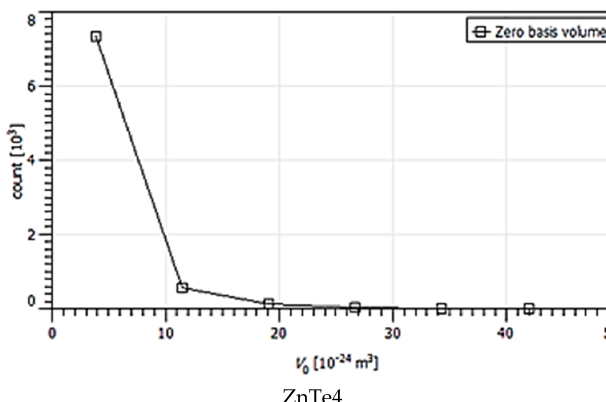
Figure 8. Zero basis volume statistic variation of ZnTe1,2,3,4 thin films. Although the surface becomes flatter when the film thickens, it can be observed that the majoritarian grain on the surfaces remained the same, i.e., ~9–10 nm radius size for all of the films. The projected grain boundary values are also quite close—from 29 to 34 nm, while surface area and grain volumes are obviously more different due to strong surface texturing and a z-range drastic decrease. The surface-to-volume ratio is the amount of the surface area per unit volume of an object or collection of objects; in this case, the grains forming the film surface. It defines the relationship between the structures and functions in processes occurring through the surface and the volume of the film/layer. For the ana- lyzed ZnTe thin films, the estimated surface to volume ratio was highest for the thinner film and was the lowest for the thicker. Additionally, the minimum circumcircle radius for each kind of grain detected on the surfaces, and the mean z-value were estimated for each above-presented AFM image, and are presented in the Figures 4–8. Table 1 presents the mean calculated values for the ZnTe films surface characteristic grains (specific surface area, grain volume, grain boundaries lengths, and surface to volume ratios) that can be further connected with the film growth mechanisms and physical properties. Based on Figures 4–8 that present the dimensional distribution of these surface characteristic pa- rameter values for each of the films, the proper estimation of majoritarian grains is con- firmed, and information regarding the other non-majoritarian grains (number and size ranges) present on the samples surfaces is provided. This offers the most complete kind of characterization regarding surface properties of the ZnTe films that one could obtain. The Figures 4–8 show the dimensional distributions of each parameter value onto the 2 μ m × 2 μ m surface scans (Figure 4). To better analyze the surface roughness evolution, examples of three-dimensional (3D) AFM images of ZnTe films obtained from larger scan sizes (5 μ m × 5 μ m) are shown in Figure 9. The z-range of the specific 3D representations was chosen to be equal to the highest feature onto the surface, as a better way to observe the regularities and irregular- ities of the specific surface roughening process determined by film thickening. It could be observed that the thicker films exhibit a waviness surface texture while the thinnest show pure grain distribution onto the surface. The growth time effect, onto surface structuring and morphology, is very strong. The thicker ZnTe film surfaces pre- sent valley regions, which become relatively smoother as the thickness increases. The cliff regions consist of spike structures that exhibit some orientation. The roughness parame- ters on surface morphology were estimated by analyzing the 5 μ m× 5 μ m topography im- ages of the sample surface (Figure 9): average values, peaks, and valleys in the height direction Ra, average amplitude in the height direction Rq, and average characteristics in the height direction Rsk.